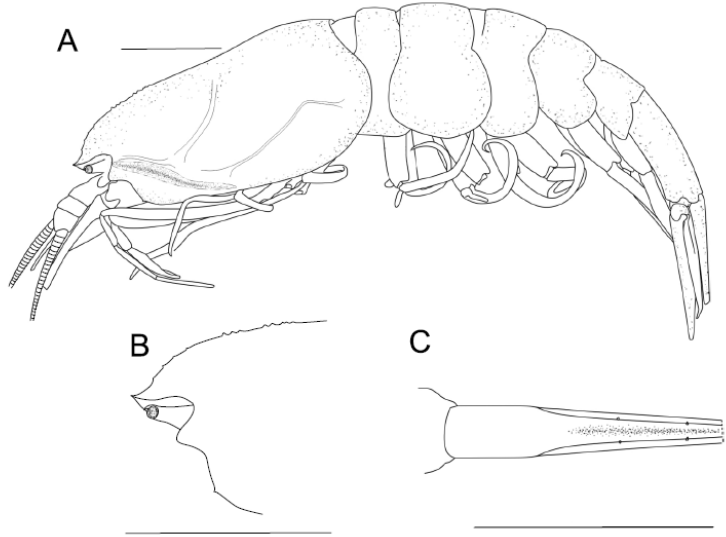
Figure 3. Body of Sclerodora crosnieri sp. nov., holotype: ( A )—general view. ( B )—anterior part of carapace, lateral view. ( C )—telson, dorsal view. All scales: 10 mm.